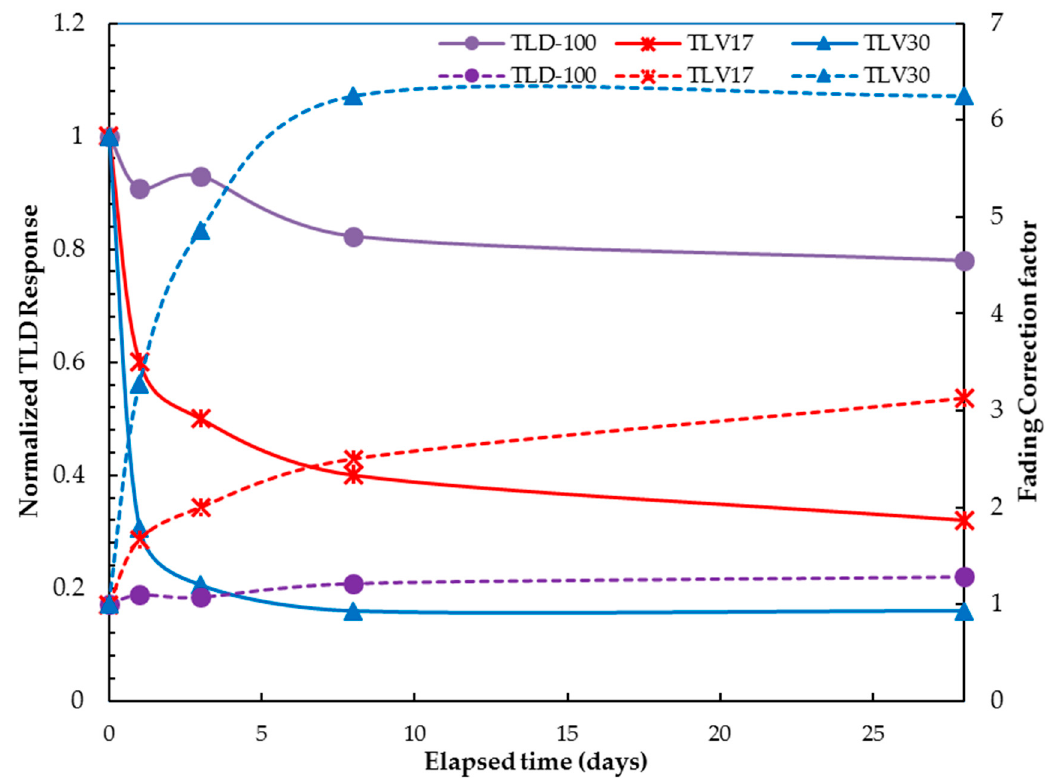
Figure 12. Fading (continues curves) and fading correction factor (dashed curves) of TLV17, TLV30 and TLD-100.